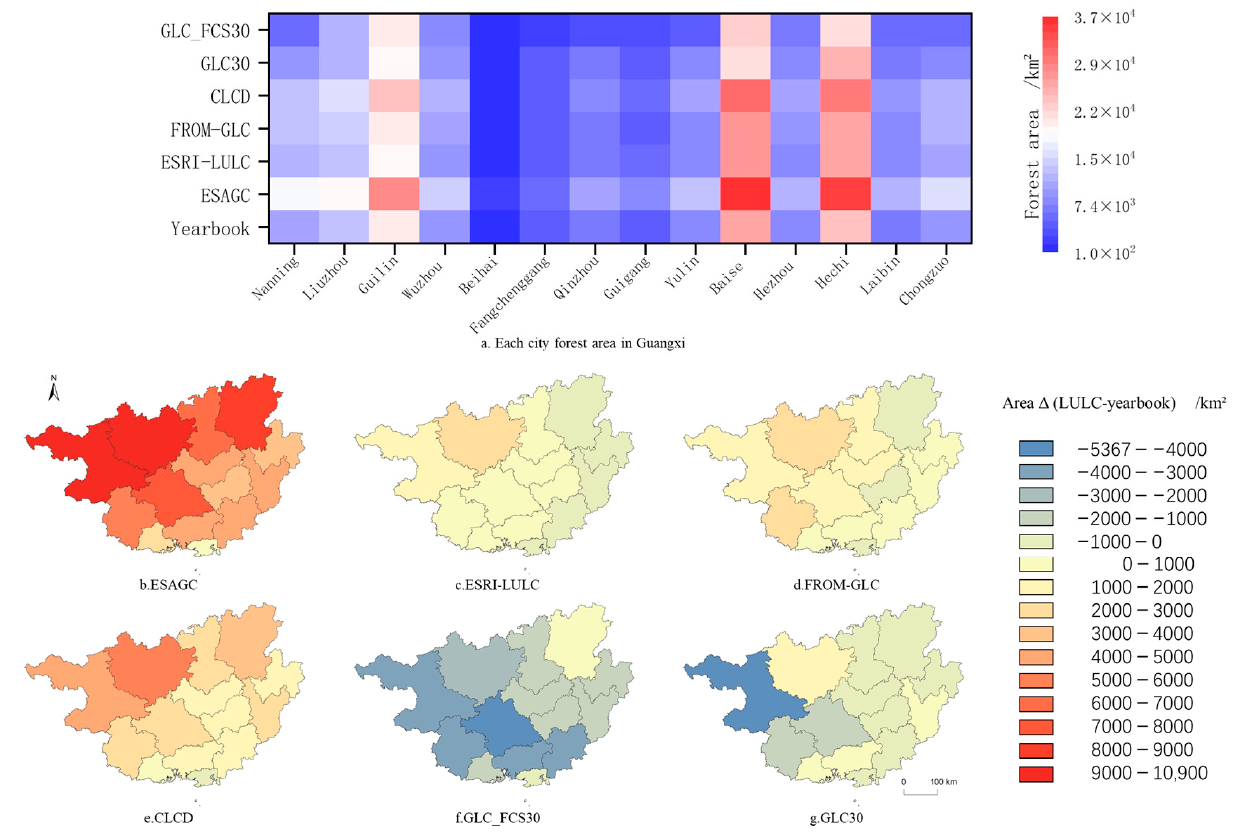
Figure 4. Area of forest at the municipal level according to the six land cover products and the statistical yearbook data: ( a ) heat diagram showing the area of forest area in each city in Guangxi for each data set; ( b – g ) the difference in forest area between the different land cover data sets and the yearbook values.